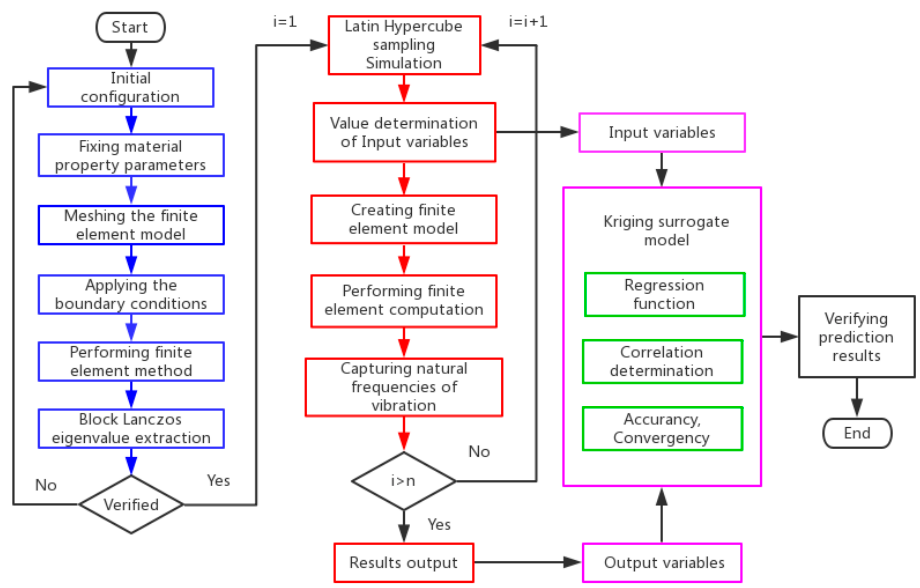
Figure 2. The flowchart of the Kriging surrogate model.